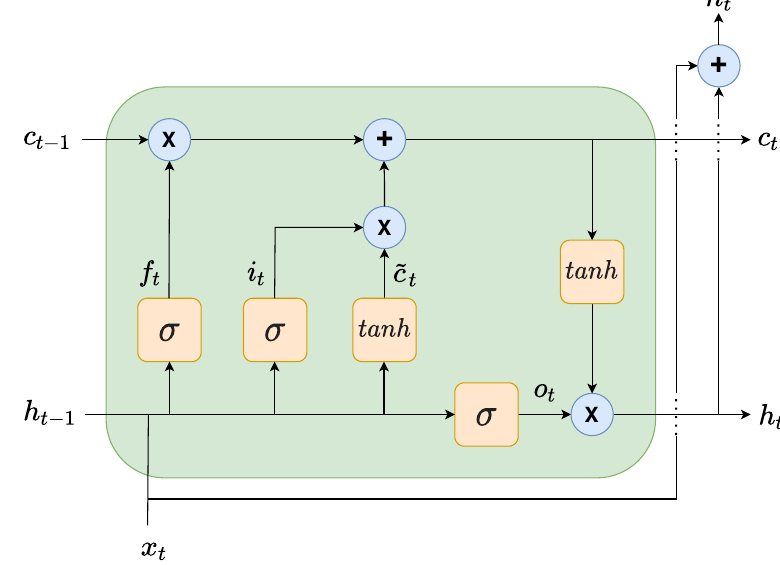
Figure 4. LSTM cell internal